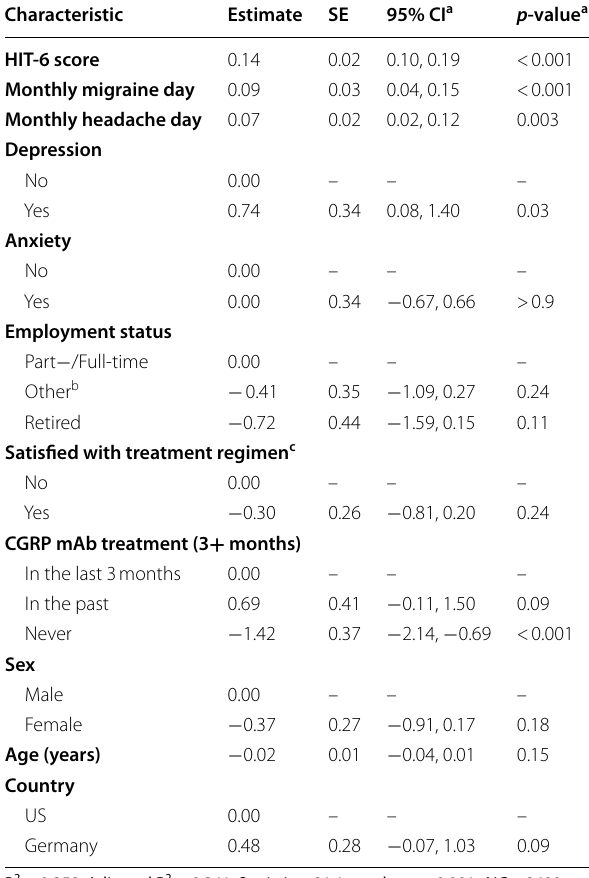
Table 3 Multivariable linear regression model of MIBS-4 scores (interictal burden). A positive estimate suggests the characteristic is associated with worse interictal burden; a negative estimate suggests it is associated with lower interictal